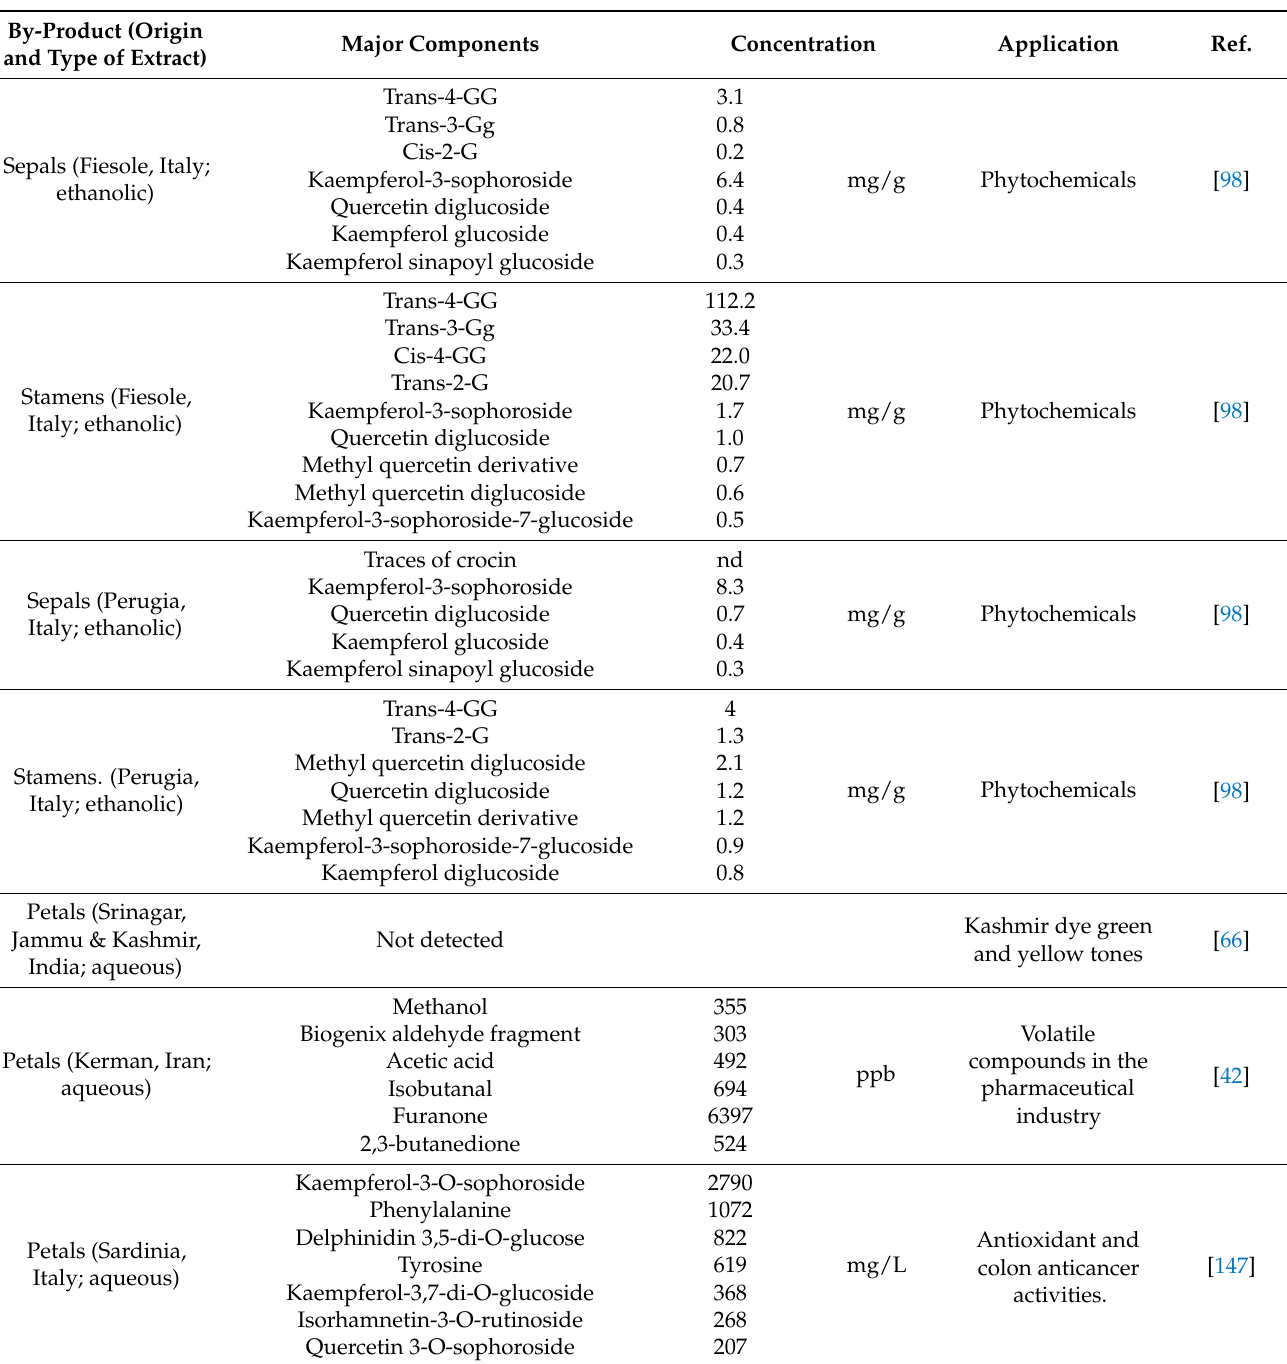
Table 3. Saffron by-products of different geographical origins, major components, and